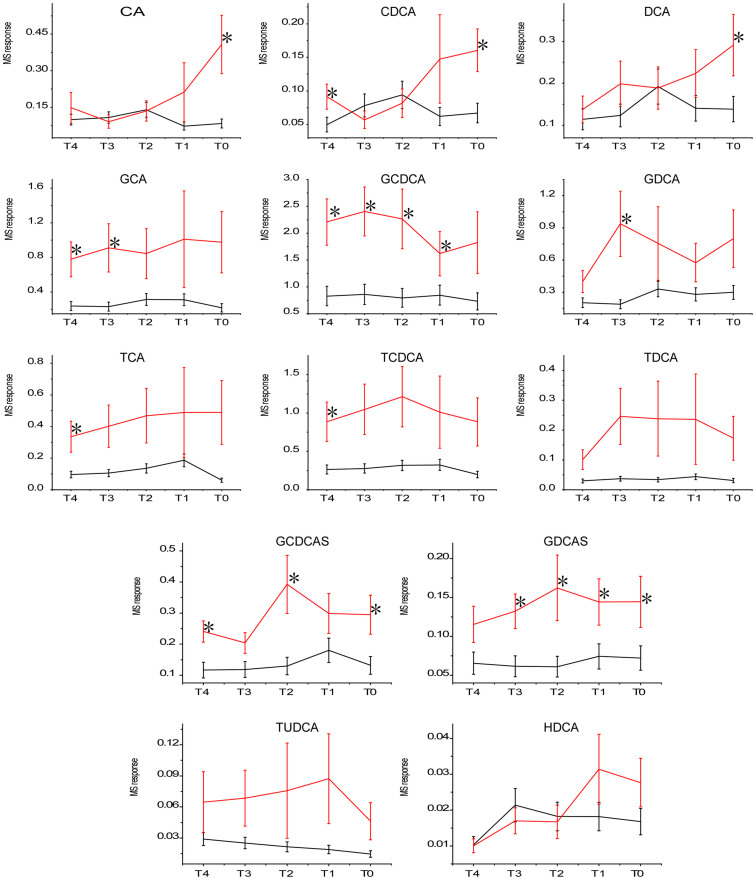
Relative content of serum bile acids in the HCC group compared to the HBsAg+ control group at paired time points.T0: the stage at which patients were initially diagnosed with HCC. Serum samples collected every 6 months prior to T0 at T1 (half a year ago), T2 (one year ago), T3 (one and a half years ago), T4 (two years ago) were then identified. Abbreviations are the same as in Table 2. * indicates significance (p < 0.05).